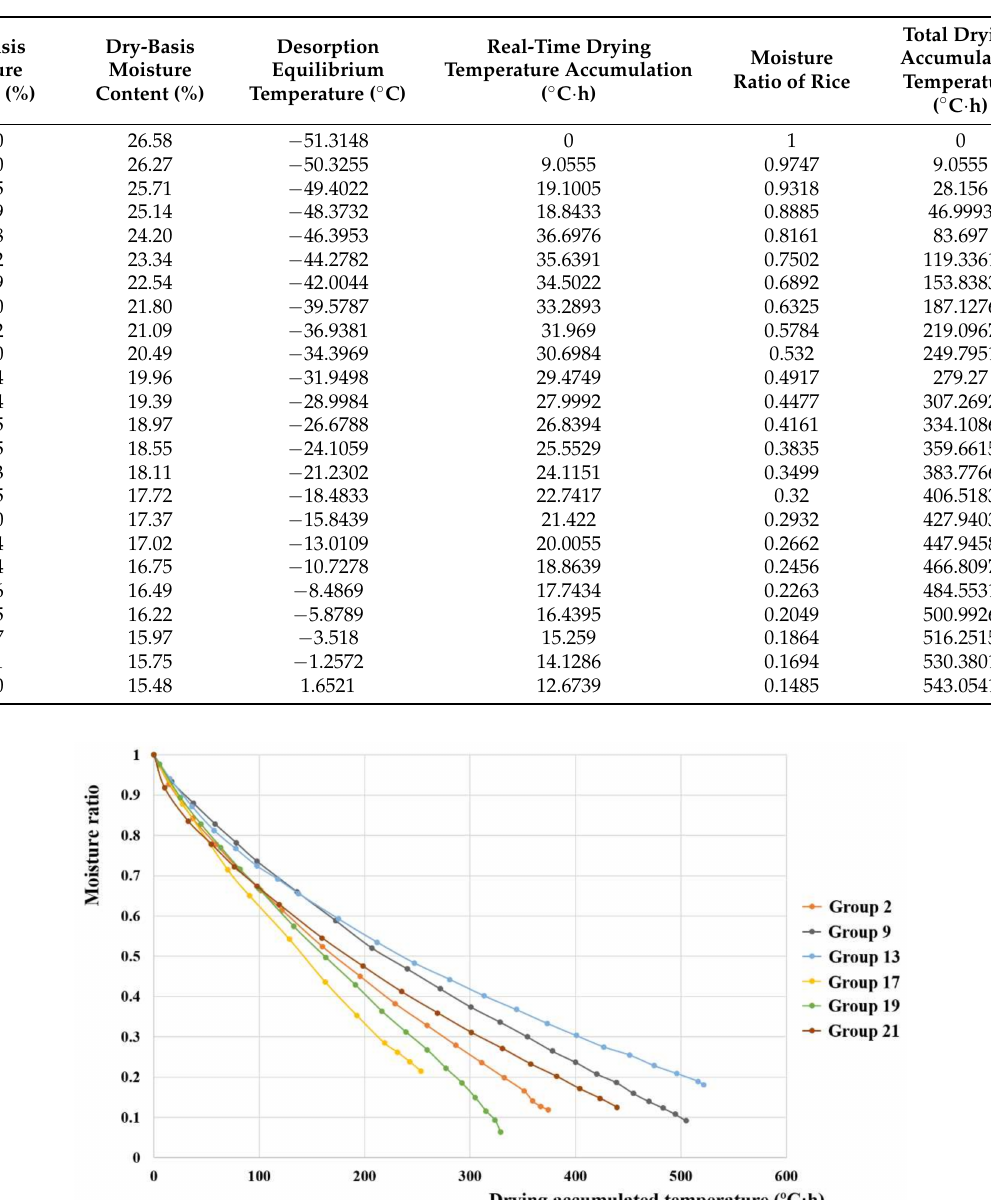
Table 3. Calculation results of moisture ratio and drying accumulated temperature.